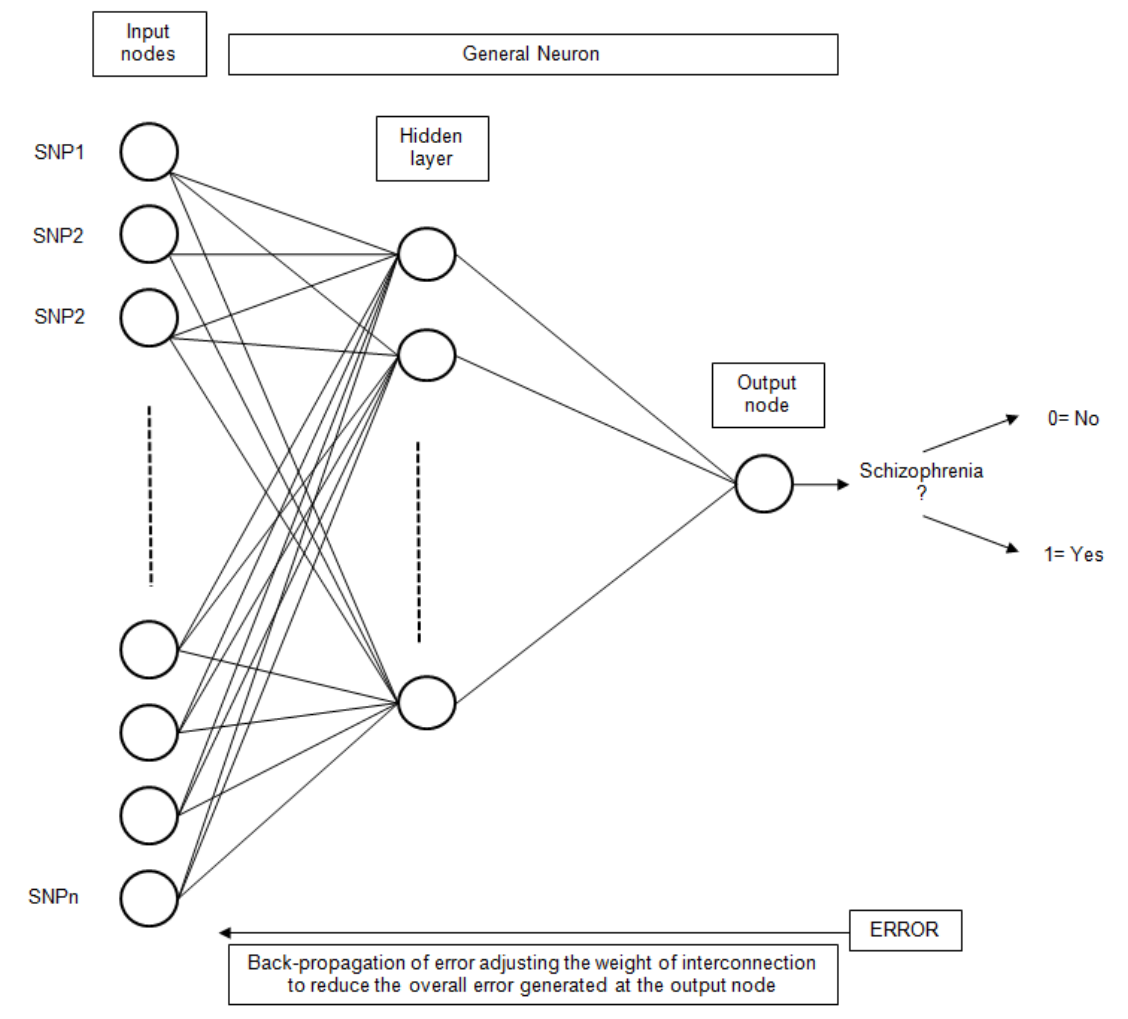
Figure 5. The general structure of an ANN for schizophrenia classification based on SNP